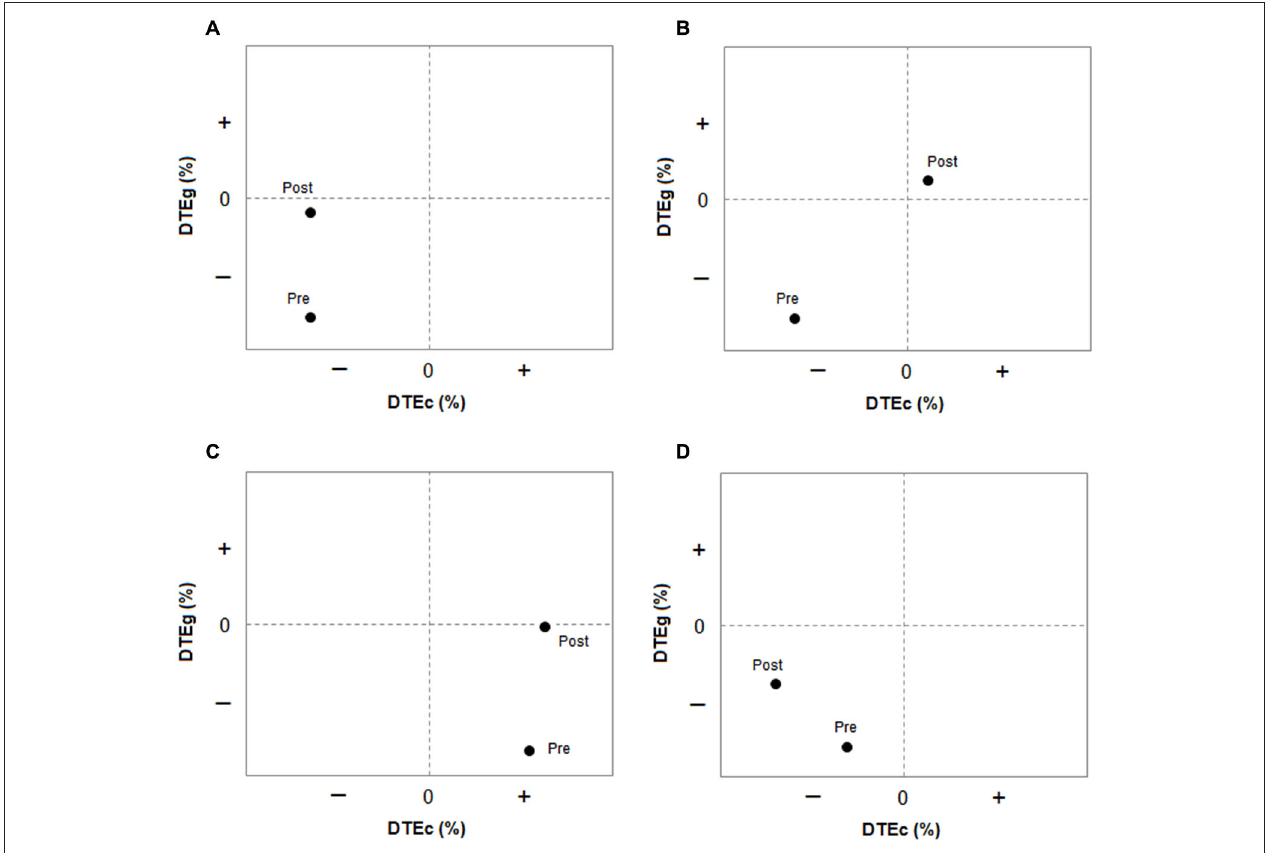
interference (with improved cognitive interference); (C) Pre = gait interference with cognitive-priority trade off, post = improved gait interference (no change in cognitive DTE); (D) Pre = mutual interference, post = improved gait interference at cost to cognitive interference (worsened), therefore, no improvement but a change in strategy for dual-task performance. Data are